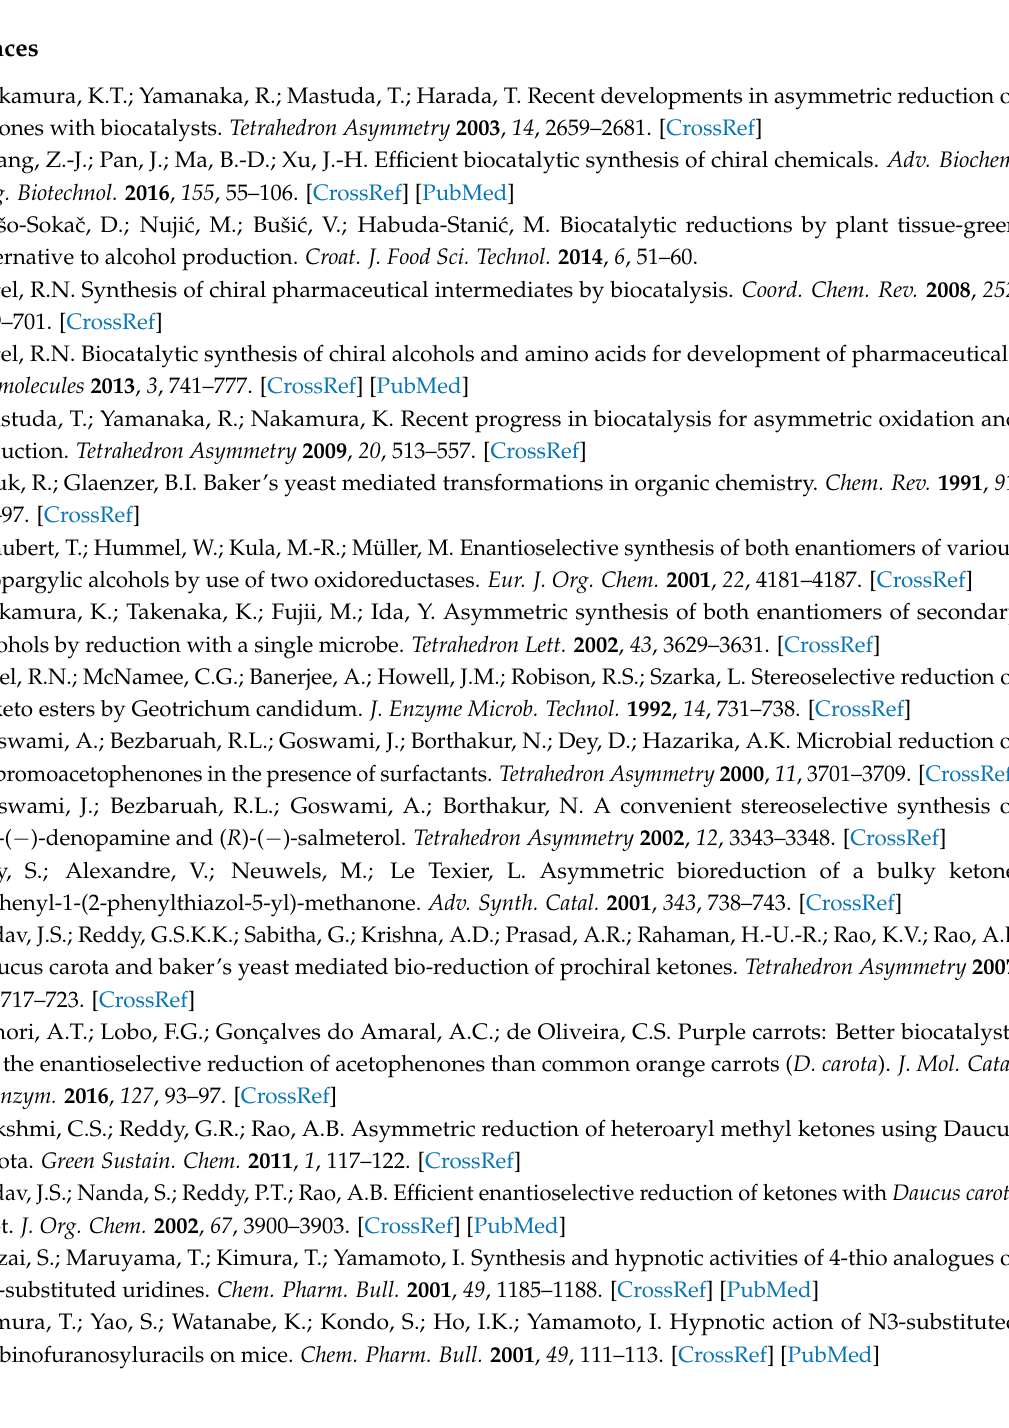
buffer solution (pH = 7.0) with glucose at 30 ◦ C; Figure S28: Reduction of 3 in phosphate buffer solution (pH = 7.0) with glucose at 33 ◦ C; Figure S29: Reduction of 3 in phosphate buffer solution (pH = 7.0) with sucrose at 30 ◦ C; Figure S30: Reduction of 3 in phosphate buffer solution (pH = 7.0) with sucrose at 33 ◦